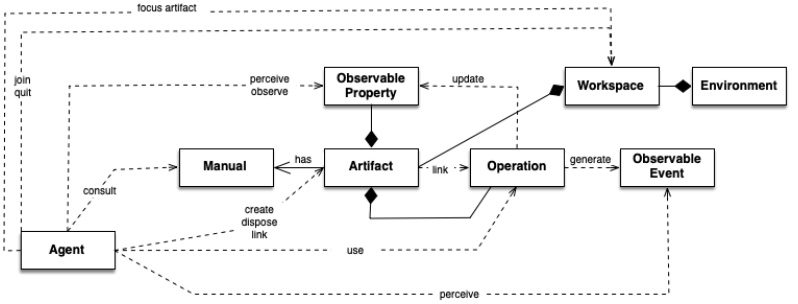
Figure 1. A&A meta-model.